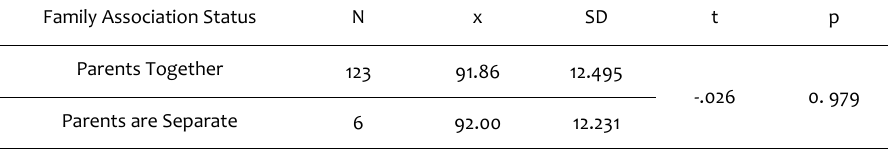
Table 11. Students' reading motivation scores in relation to family togetherness Family Association Status